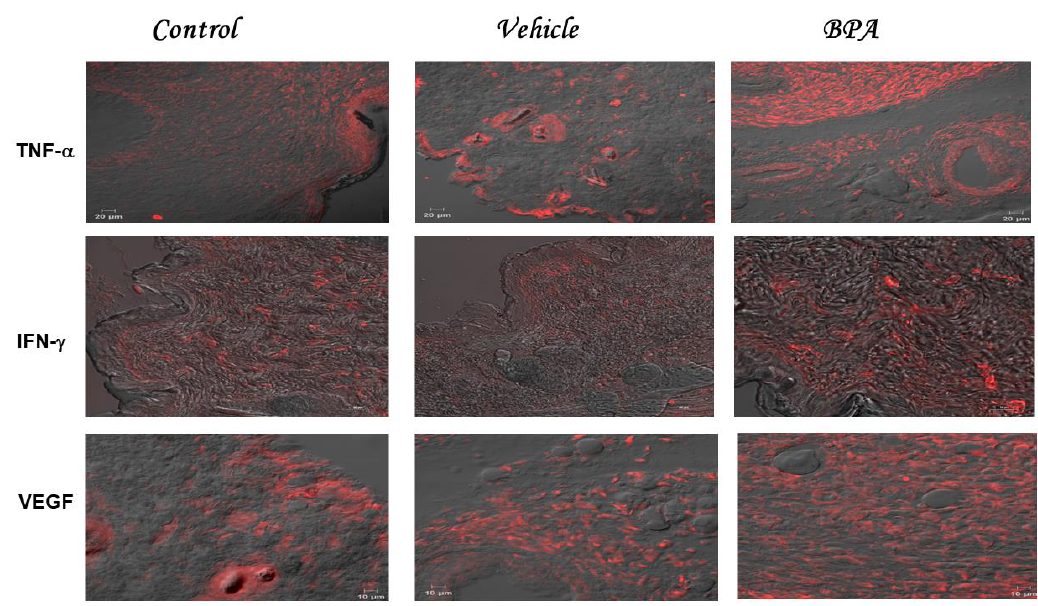
Figure 2. Intratumoral expression of cytokines. Representative images belonging to the intratumoral expression of TNF- α, IFN - γ, and VEGF corresponding to the three experimental groups, namely control, vehicle, and BPA, are shown. The staining was performed with rhodamine and pictures were taken in a confocal microscope, using Newarsky contrast, being red the cytokine expressed and gray the non-stained tumor. Table 2. Summary of the quantitation of immunofluorescence cytokine (TNF- α and IFN - γ) and VEGF staining in tumors. It shows the obtained MFI (Mean Fluorescence Intensity) (+SD) of the different experimental groups. It is highlighted the results that were considered statistically signif- icant * p < 0.05, ** p < 0.01, *** p < 0.001.